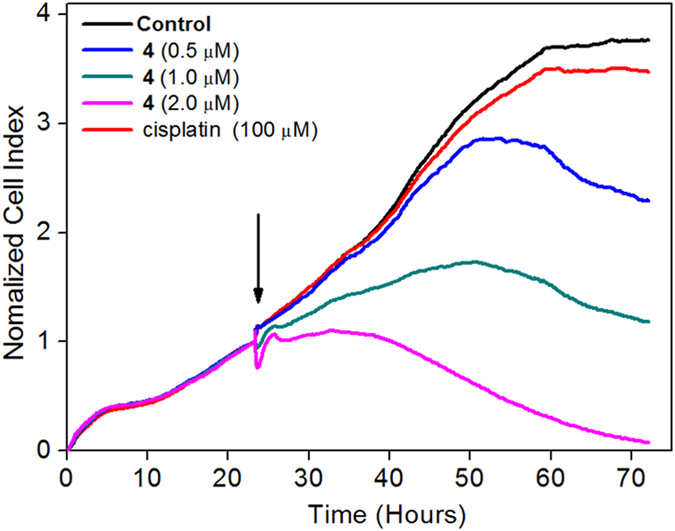
Kinetics of cytotoxicity responses for complex 4 in A549R cells monitored by the xCELLigence system.The arrow signifies the time of complex 4 addition.